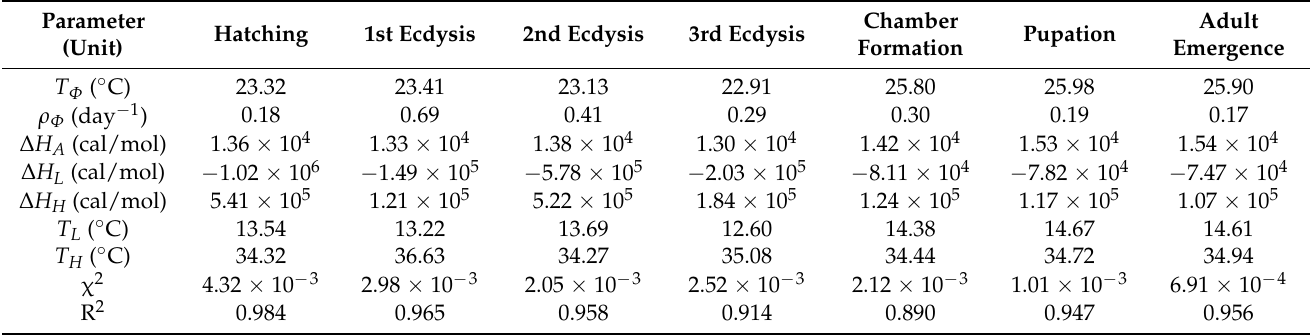
Table 3. Parameter estimates for different developmental stages of Necrobia ruficollis according to the curvilinear thermodynamic model (Optim SSI) of Shi et al.